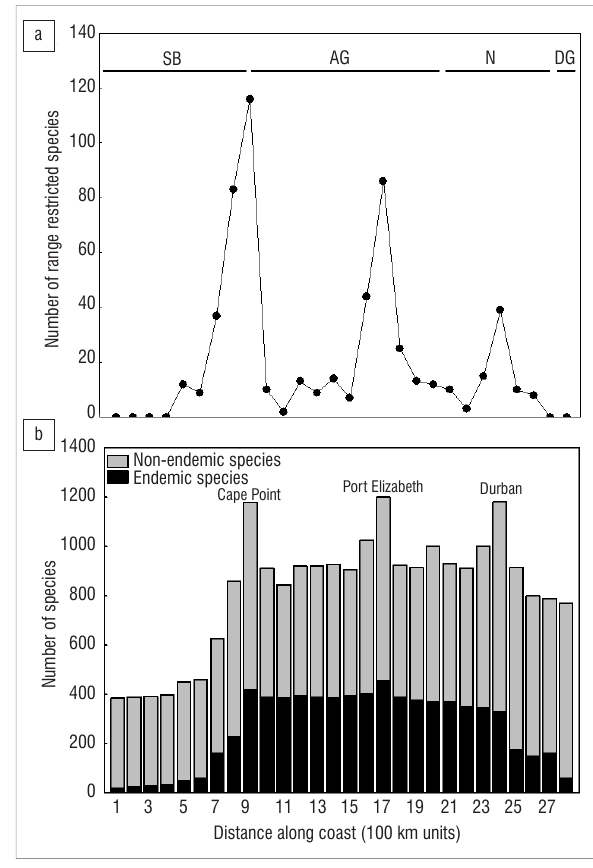
Figure 2: (a) Numbers of range-restricted (range<300 km) species/ 100 km stretch of coastline and (b) marine invertebrate species richness/100 km. Distance around coast measured from Namibian border to Mozambique border. Data from Awad et al. 10 Ecoregions described by Sink et al. 28 are indicated in panel (a) as SB (Southern Benguela), AG (Agulhas), N (Natal) and DG (Delagoa). The dark sections of the bars in panel (b) indicate endemic